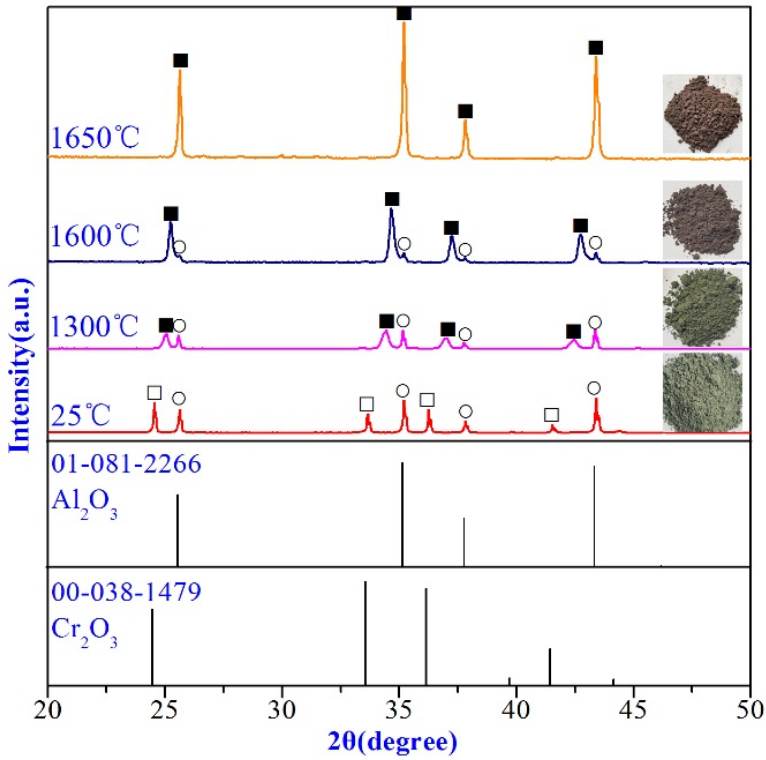
Figure 1. XRD pattern of (Al 1-x Cr x ) 2 O 3 solid solution pre-synthesized at different temperatures. ○ - Corundum (Al 2 O 3 ), ■ -(Al 1-x ,Cr x ) 2 O 3 solid solution, □ -Eskolaite (Cr 2 O 3 ). Table 4. Relative Cr(VI) reduction (%) of specimens compared to R at different